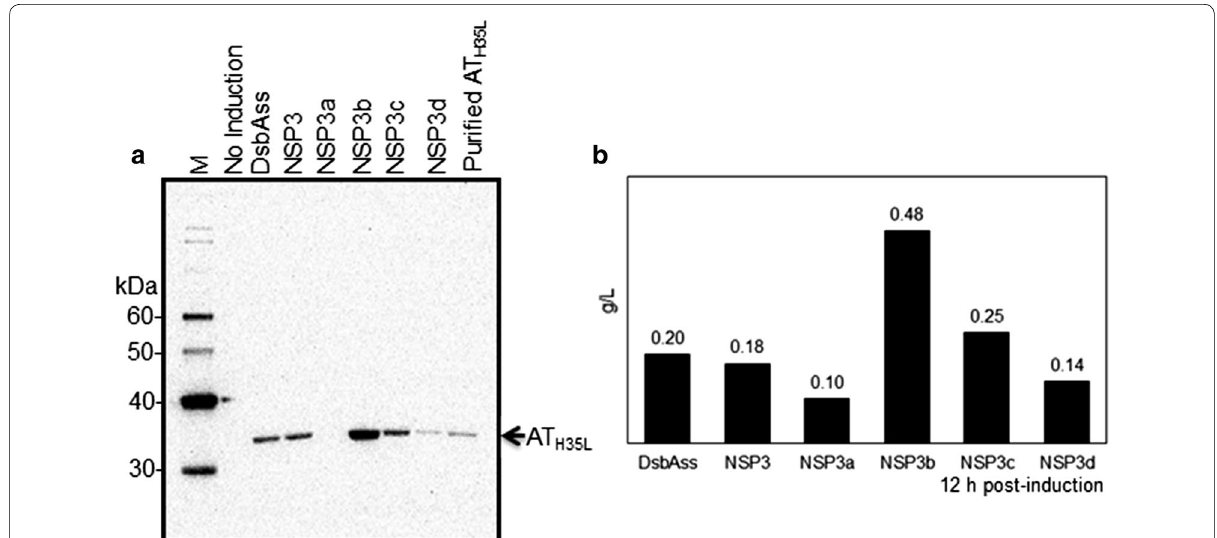
Fig. 5 Screening of Set III novel signal peptides for AT H35L secretion in 1L fed-batch bioreactor. a Western blot and b quantification of extracellular AT H35L protein in cell culture medium at 12 h post-induction